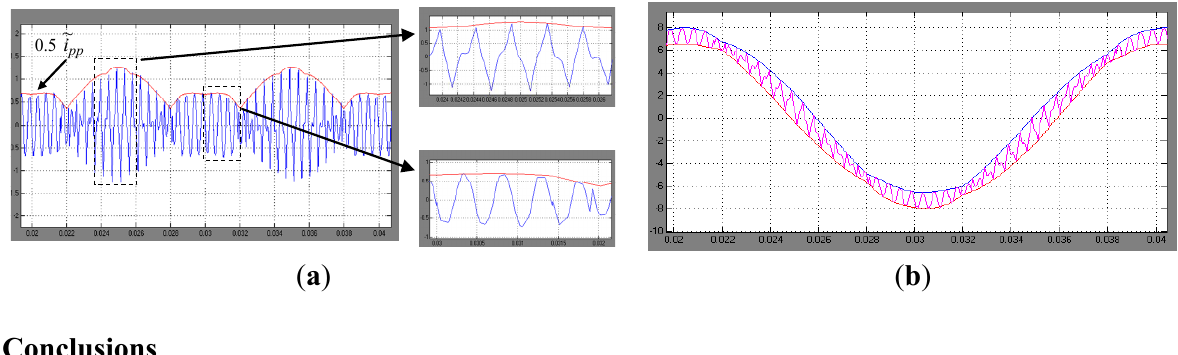
Figure 12. Current ripple for m = 0.513 ( ≈ m peak-to-peak amplitude (red envelope) for one fundamental period, with details; ( b ) instantaneous output current with calculated ripple envelopes (red and blue traces). i~ pp